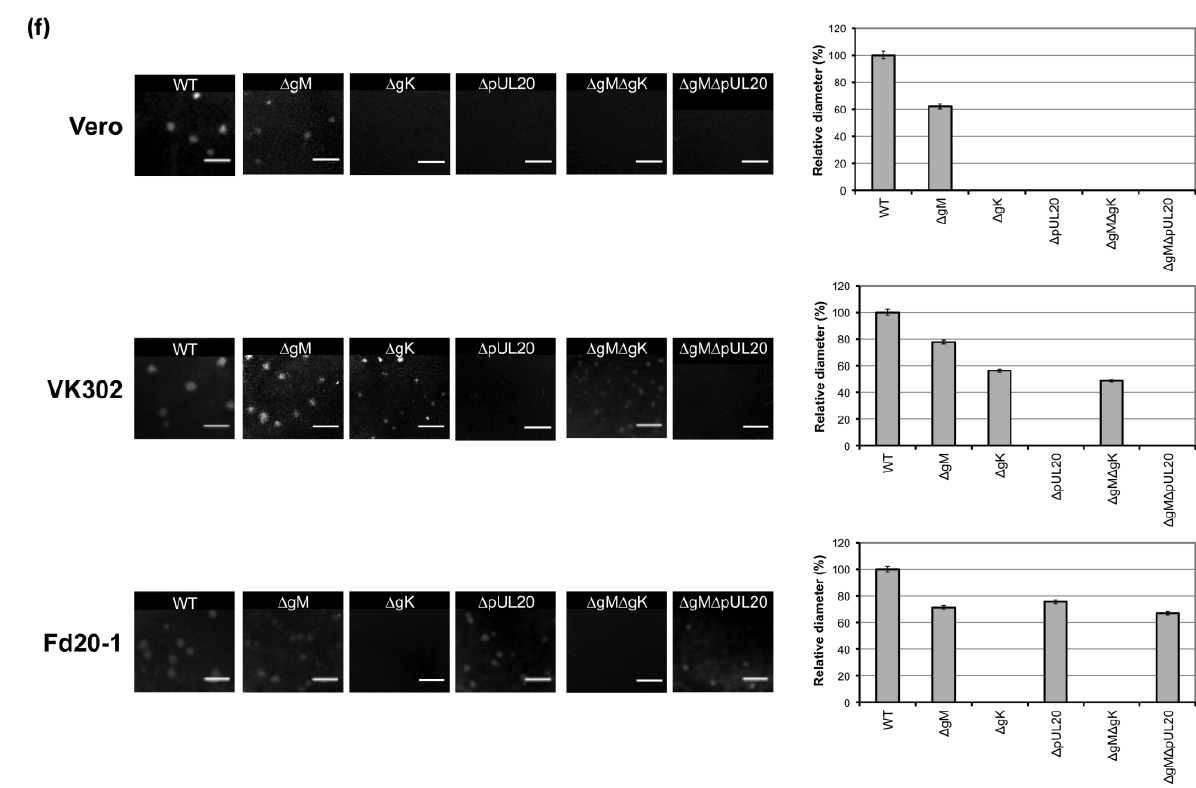
Figure 3. Replication kinetics, plaque formation and protein expression of recombinant viruses. Single-step growth curves at high MOI (10 PFU/cell) were carried out in Vero cells ( a , b ); VK302 cells ( c ); or Fd20-1 cells ( d ). Total infectious virus yields were determined by plaque assay using the appropriate complementing cells lines. Error bars represent standard errors of the means of triplicate samples; ( e ) HaCaT cells were infected with the indicated viruses at high MOI (5 PFU/cell) for 24 h before being harvested and lysates separated by SDS-PAGE and analysed by Western blotting using the indicated antibodies. Molecular mass markers (in kDa) are indicated on the right; ( f ) Plaque formation of the indicated viruses was determined by standard plaque assay on Vero, VK302 and Fd20-1 cells at 3 days post infection. Representative images are shown. Scale bars: 2.5 mm. Plaque sizes were determined by scanning assay plates and measurement using Photoshop. The relative diameters compared to WT are shown. Error bars represent standard error ( n =